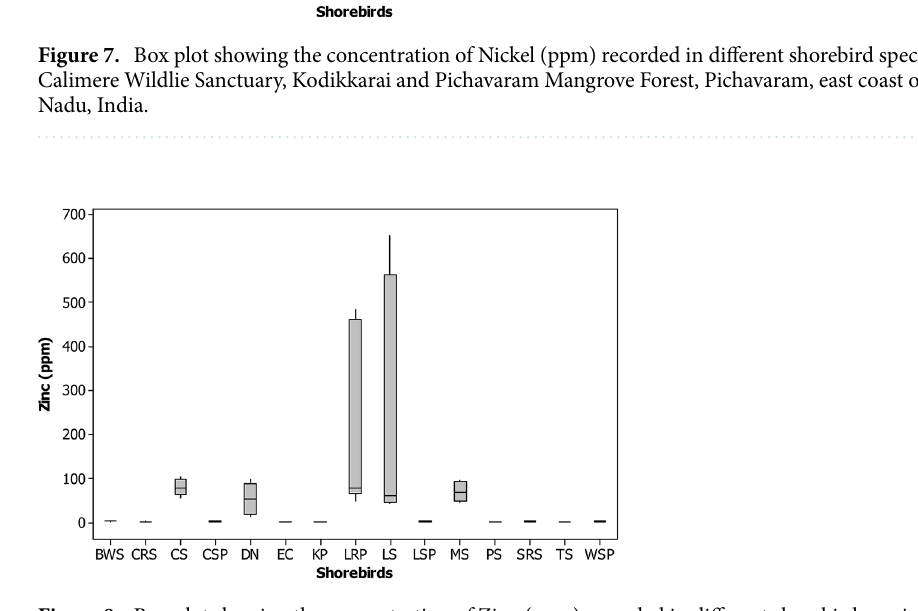
Figure 8. Box plot showing the concentration of Zinc (ppm) recorded in different shorebird species at Point Calimere Wildlie Sanctuary, Kodikkarai and Pichavaram Mangrove Forest, Pichavaram, east coast of Tamil Nadu,